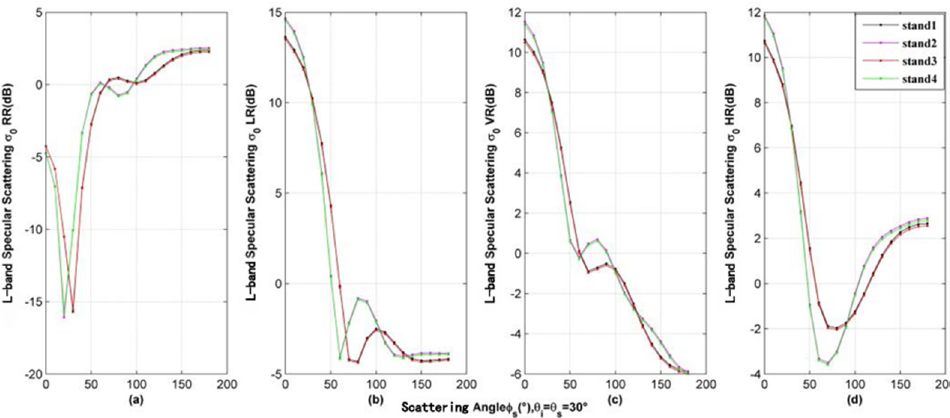
Figure 5. Specular scattering properties of four stands’ diameters at various polarizations. ( a ) RR polarization; ( b ) LR polarization; ( c ) VR polarization; ( d ) HR polarization.